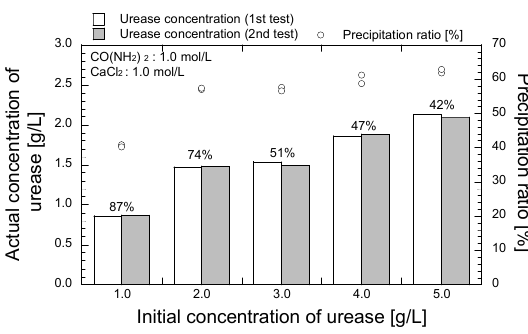
Figure 3. Evaluation of consumed urease and its effect on the precipitated ratio.